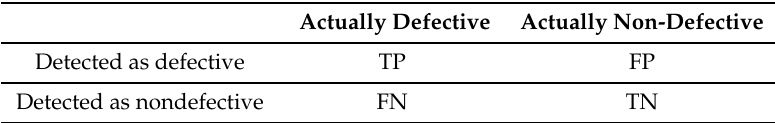
Table 5. Definitions of TP, FP, TN, and FN in defect detection.